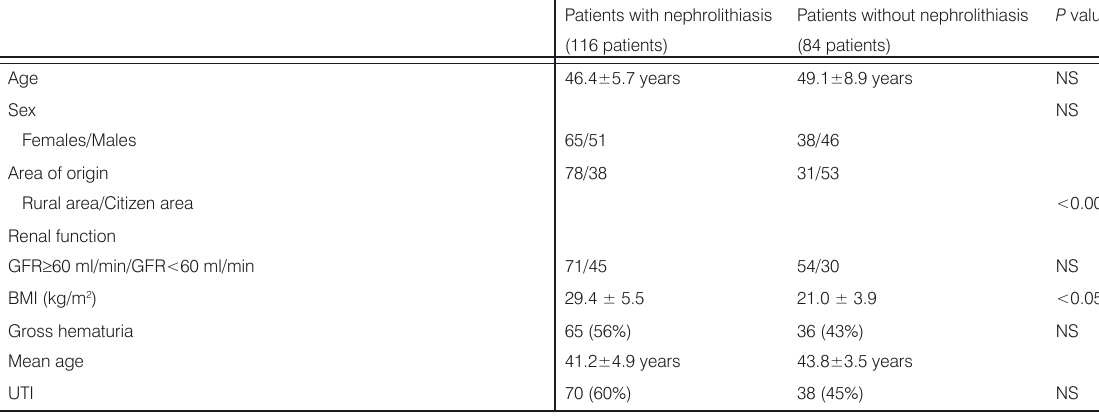
Table 1. Demographic data of